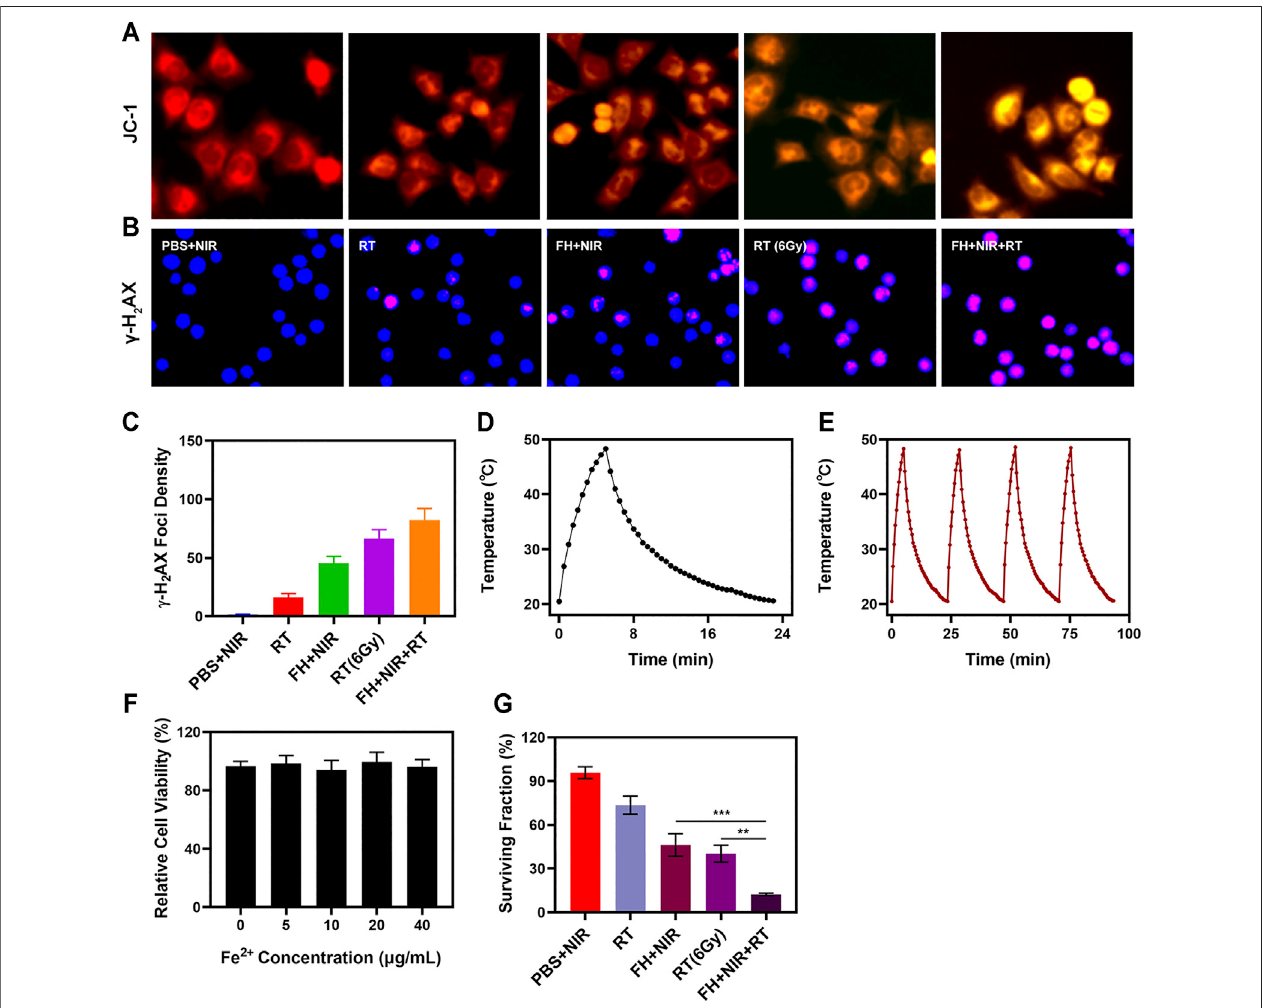
FIGURE2|(A) JC-1(greenforJC-1monomerandredforJC-1aggregate fl uorescenceimageunderdifferenttreatment. (B) DAPIand c -H2AXstainingwereused to respectively visualize nuclear condensation and DNA fragmentation in cells treated as indicated, with representative images being shown. (C) The density of c -H2AX foci was determined based on analyses of 100 cells per treatment group ( c -H2AX foci/100 μ m 2 , n (cid:2) 3). (D) Temperature pro fi le of a FeGA solution at 200 μ g/ml upon heating when the laser is on and subsequent cooling once the laser is turned off. (E) Temperature variations of a FeGA solution over four cycles of heating and natural cooling. (F) Dark cytotoxicity of FeGA on 4T1 cells. (G) Colony formation assays were conducted using 4T1 cells treated with radiation ( n (cid:2) 3). ** p < 0.01, *** p < 0.005; Student ’ s t -test.